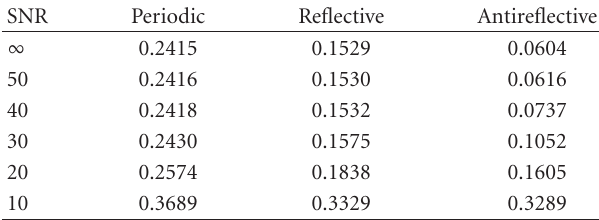
Table 3: Test II: best RREs for CG with reblurring varying the SNR (SNR = ∞ means 0% of noise) within 200